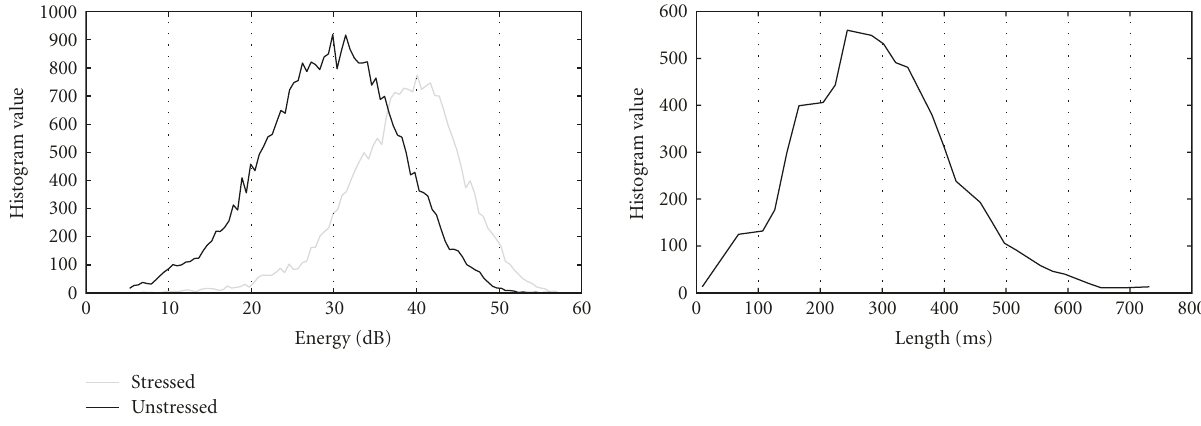
Figure 3: Representation of the 4 features: (a) Formants, (b) Pitch, (c) Energy, (d)